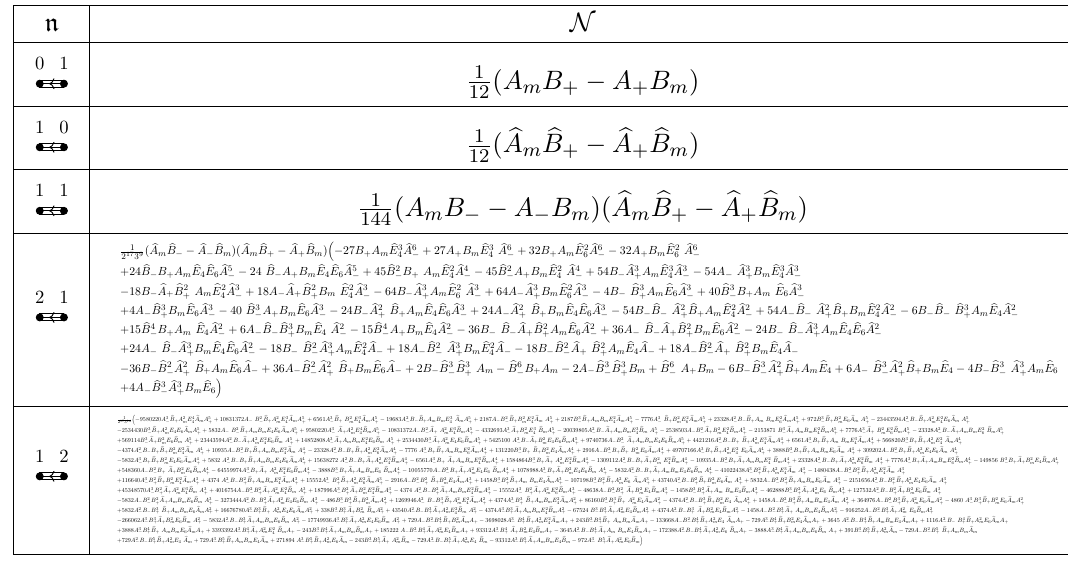
Table 9 . Elliptic genera of G 2 . Here, A z = A z ( τ ) , b A z = A z (3 τ ) , and same for B z . n